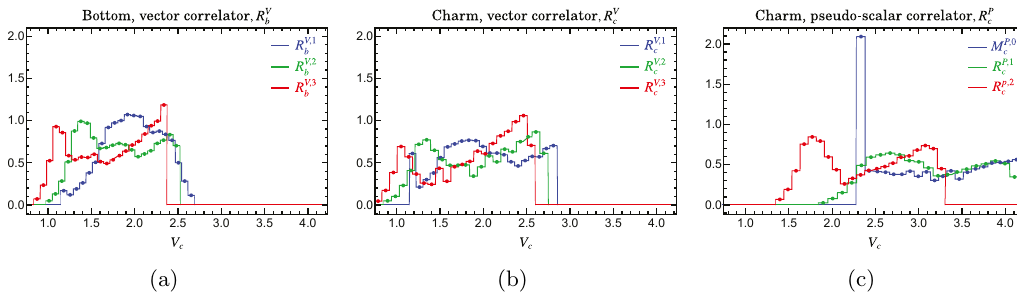
Figure 6 . V c distribution for the series corresponding to: ratios of the vector correlator for n f = 5 (bottom) [ panel (a) ]; ratios of the vector correlator for n f = 4 (charm) [ panel (b) ]; charm pseudo- scalar correlator, 0-th moment (blue), and (cid:12)rst two ratios (green and red). For panels (a) and (b) blue, green, and red correspond to the (cid:12)rst, second, and third ratios of moments, respectively. The parameter V depends on the tuple ( (cid:22) ; (cid:22) ), and the values obtained in the c (cid:11) m